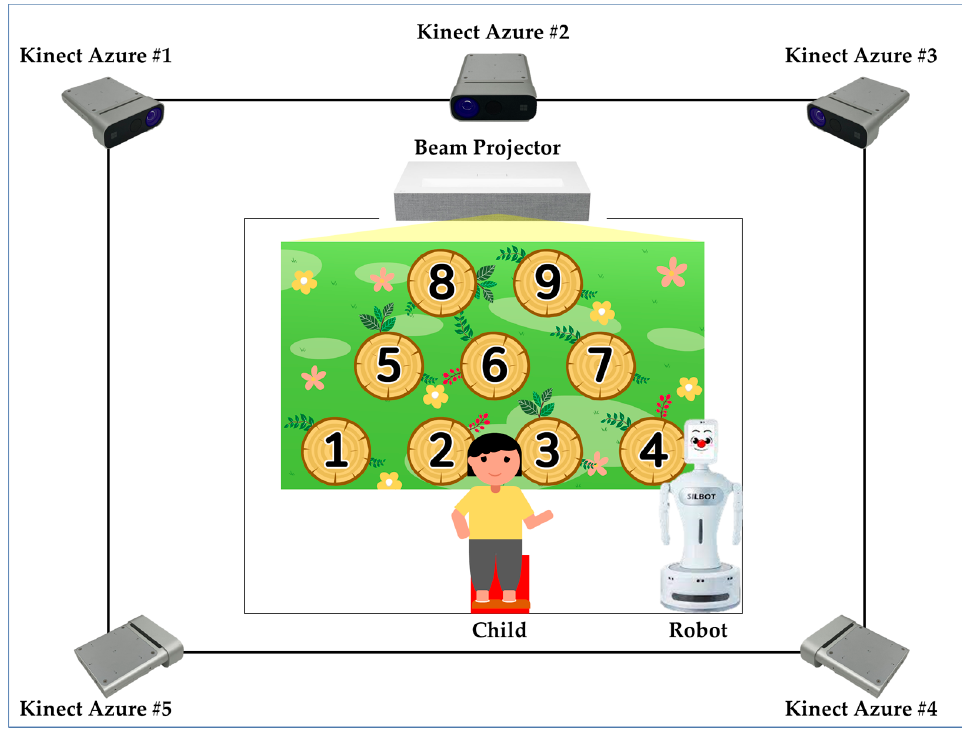
Figure 2. The data acquisition environment of the screening games.